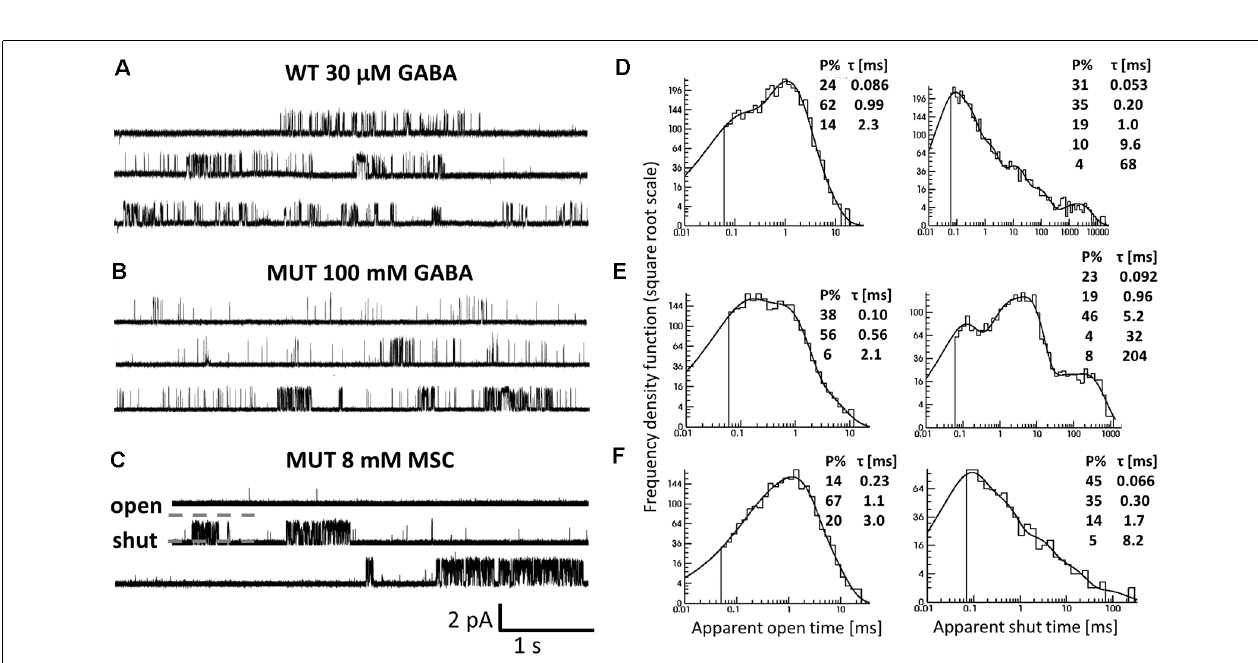
FIGURE 6 | The impact of β 2 E155C mutation on the single-channel activity of α 1 β 2 γ 2 receptors. (A–C) Typical traces of single-channel currents mediated by WT receptors evoked by 30 µ M GABA (A) and for mutants (MUT) elicited by 100 mM GABA (B) and 8 mM MSC (C) . (D–F) Typical dwell-time distributions (left: openings, right: closures) for single-channel recordings presented in (A–C) . Insets in each distribution presents time constants ( τ ) and percentages (P % > 1) of specified